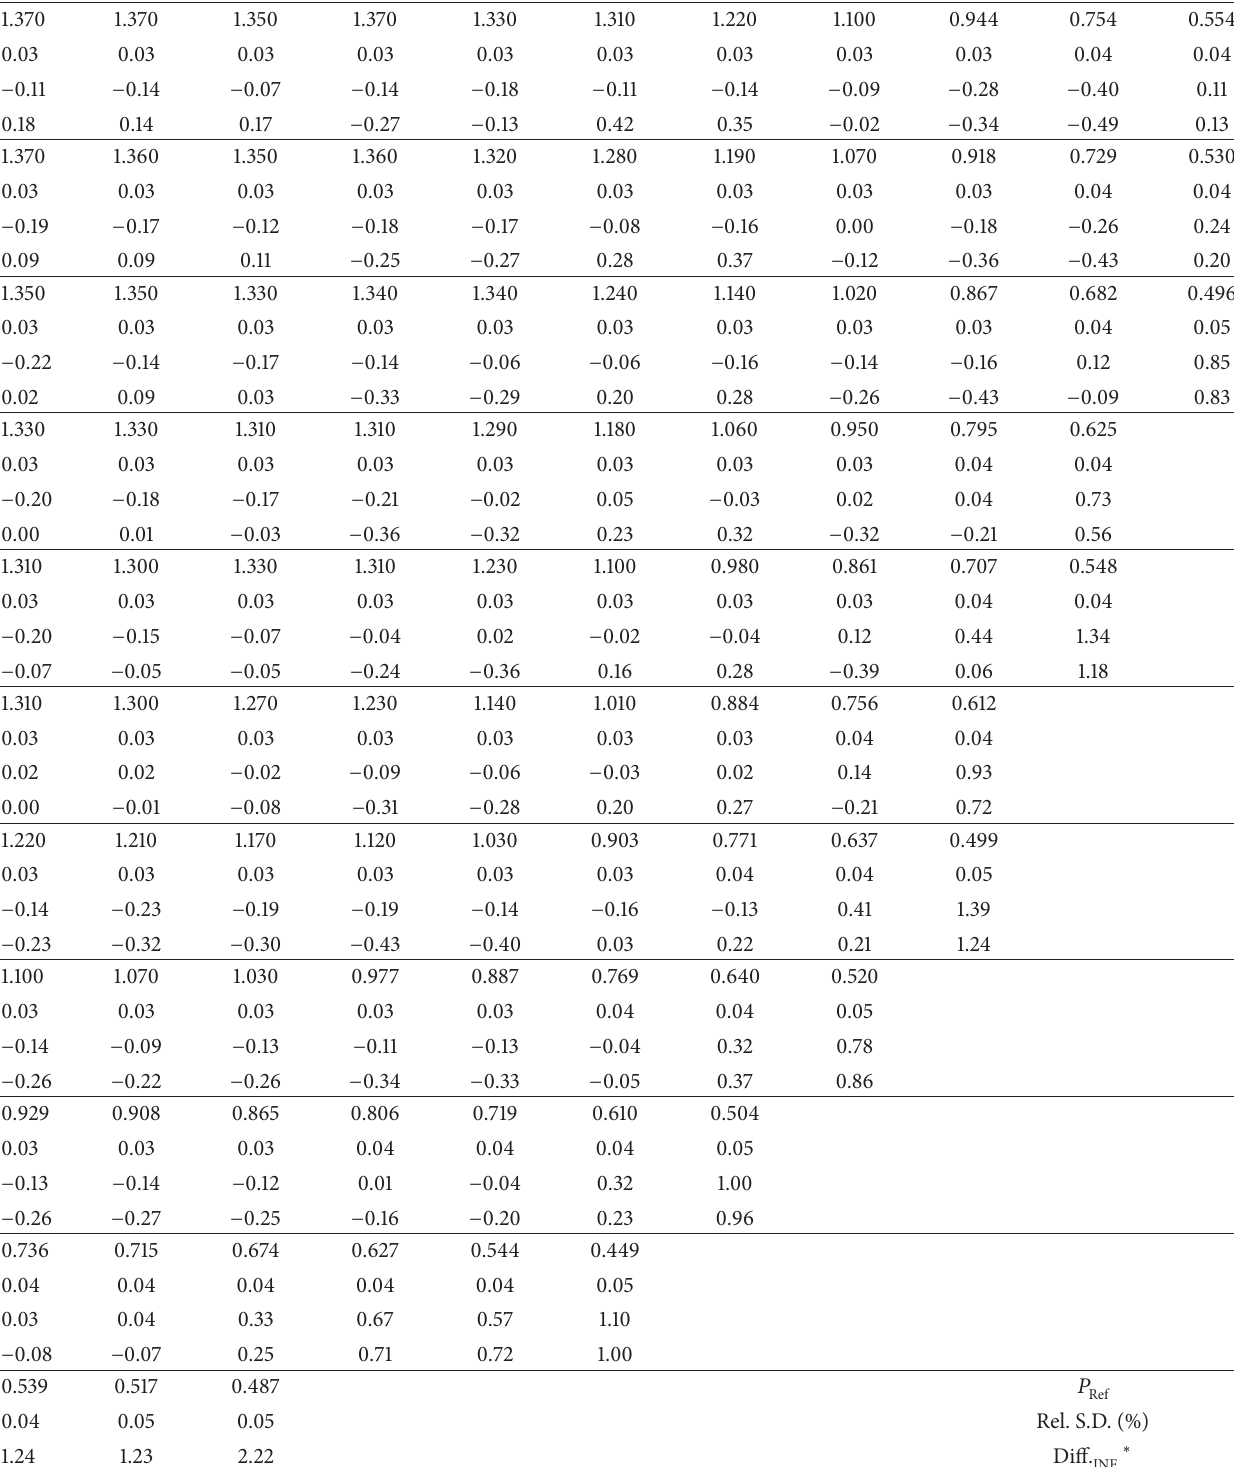
Table 6: Comparison of normalized channel power distribution for the control-device-free